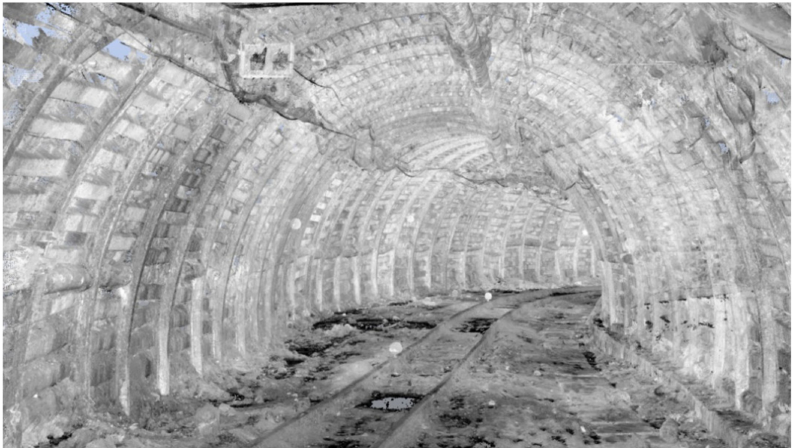
Figure 2. ‘Inside’ view of a mine gallery section before a bend–point cloud.